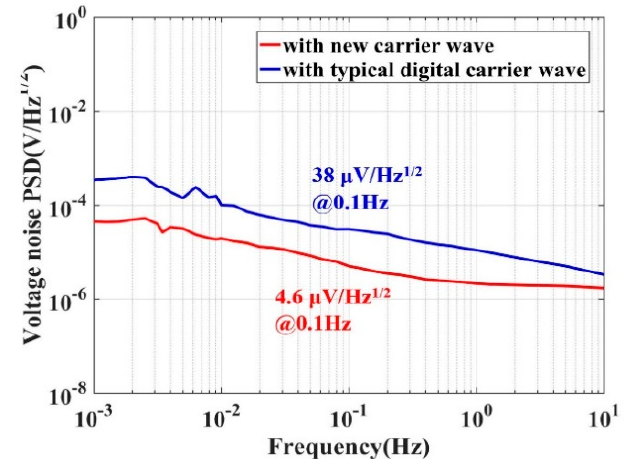
Figure 6. A comparison of capacitive transducers, with different carrier waves, allowing the output to reach the maximum value of 5 V. The red line represents the new carrier wave, while the blue one represents the typical direct digital synthesis (DDS) carrier wave.